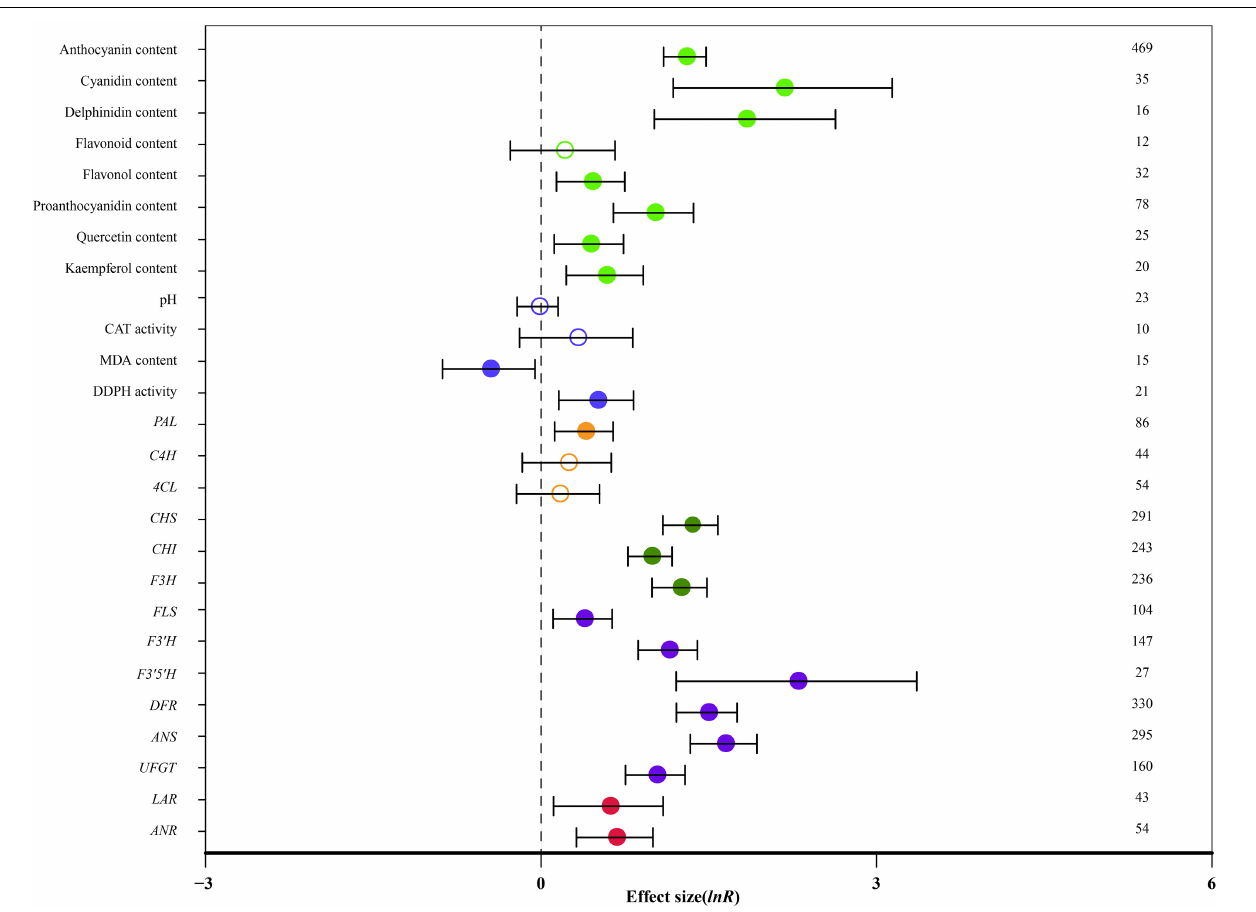
FIGURE 1 | Effect of MYB overexpression on the 26 summary effect sizes (natural log of the response ratios of TC/NC plants, ln R ). Ratios are unit-less. The ratios illustrate the strength of MYB overexpression on summary effect sizes compared with the controls. Circles and horizontal bars indicate the summary effects and the 95% CI, respectively. Numbers represent the number of studies contributing to each summary effect. The characteristics of the examined plants are colored and distinguished by different colors. Closed and open circles indicate the effects of significance and insignificance,